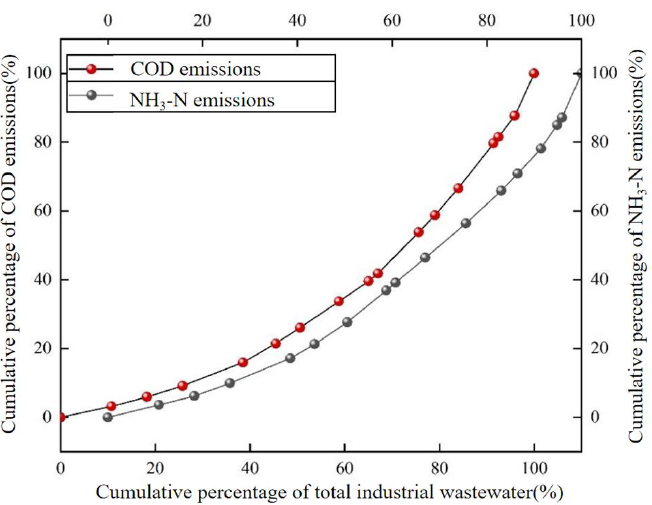
Figure 6. Lorenz curves of COD and NH 3 -N based on total industrial output indicators.